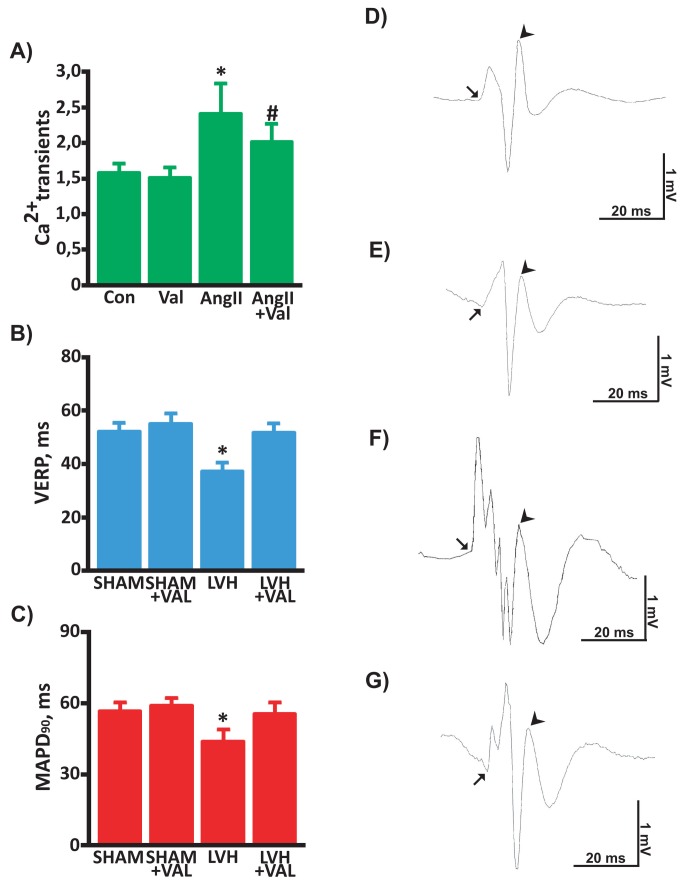
Valsartan modulation of electrophysiological properties in
vitro and in
vivo.
A: Bar graph demonstrating average peak systolic amplitude of the calcium transients, expressed as absolute numbers from ratio between the peak of fluorescence intensity (F) and the intensity at rest (F0): AngII stimulation (10-6mol/L; 24 hours) augmented transients in cultured myocytes, which were attenuated by the AngII type 1 receptor blocker valsartan. Valsartan alone did not change the amplitude of calcium transient. The mean peak F/F0 was significantly higher in AngII–treated cells than control cells (*p<0.05 vs. all, # p<0.003 vs. Con and AngII). B: Ventricular effective refractory period (VERP) was dramatically reduced in LVH (37.3±3.4ms) compared to SHAM (52.3±2.6ms), SHAM+VAL (55.1±3.3ms), and LVH+VAL (51.9±2.9ms, *p<0.001 vs. all). C: Monophasic action potential duration at 90% repolarization (MAPD90) was significantly shortened in hypertrophic hearts (LVH= 44.0±4.3ms) as opposed to control groups (SHAM= 56.7±2.9ms; SHAM+VAL= 59.1±2.5ms), whereas valsartan significantly prolonged it (LVH+VAL= 55.6±4.3ms *p<0.001 vs. all). D through G: Representative endocardial ventriculograms recorded from the right ventricles indicating normal myocardial conduction in SHAM (panel D) and in SHAM+VAL (panel E), whereas conduction dispersion was observed in LVH (panel F) and LVH-VAL (panel G), the latter showing same duration in ventricular activation compared to SHAM and SHAM+VAL. Arrows indicate onset of ventricular depolarization, arrow-heads indicate end of ventricular depolarization, followed by abnormal repolarization in hypertrophic hearts, which was more pronounced in LVH (panel F, see Table 2 for data).